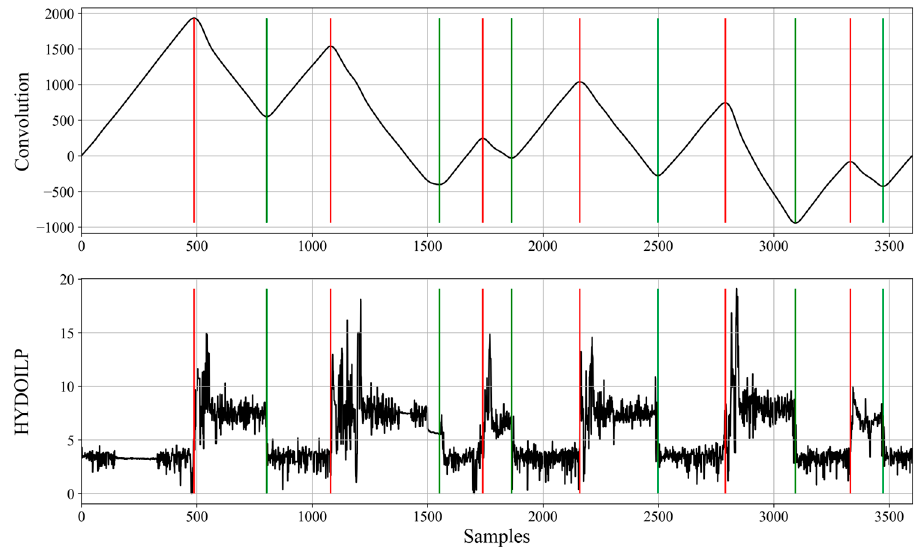
Figure 3. The convolution signal of the HYDOILP variable with unit jump that was used for cycles detection along with the raw HYDOILP variable and critical moments marked (unloading—green, loading—red).